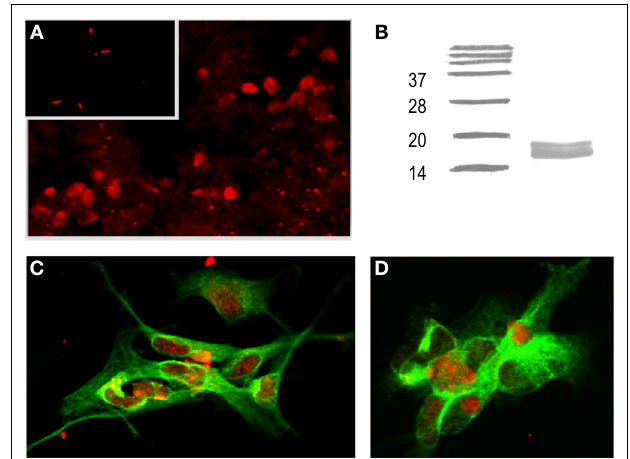
FIGURE 1 | Panel (A) demonstrates a cerebellar section treated in the absence of blocking peptide, and the inset shows an adjacent section treated after co-incubating the antibody with the blocking peptide. As noted, the blocking peptide completely prevented the ability of the antibody raised against the cleaved form of caspase-3 to recognize cleaved caspase-3 in Bergmann cells. Faintly stained cells are presumed epithelial cells. Panel (B) is a Western blot analysis of extracts from HeLa cells treated with cytochrome c (0.25 mg/ml in vitro ) using the cleaved polyclonal caspase-3 antibody to demonstrate the antibody specifi city. The left hand column is molecular weight markers, and the right hand column shows authentic cleaved caspase- 3 at 17 and 19 kDa. Panels (C) and (D) illustrate cultured Bergmann glia co- labeled with either a polyclonal (C) or monoclonal (D) antibody for cleaved caspase-3 (red, Alexa 594), and TU-01 (green, Alexa 488), an antitubulin antibody that selectively labels Bergmann glia. Note the consistent nuclear label for cleaved